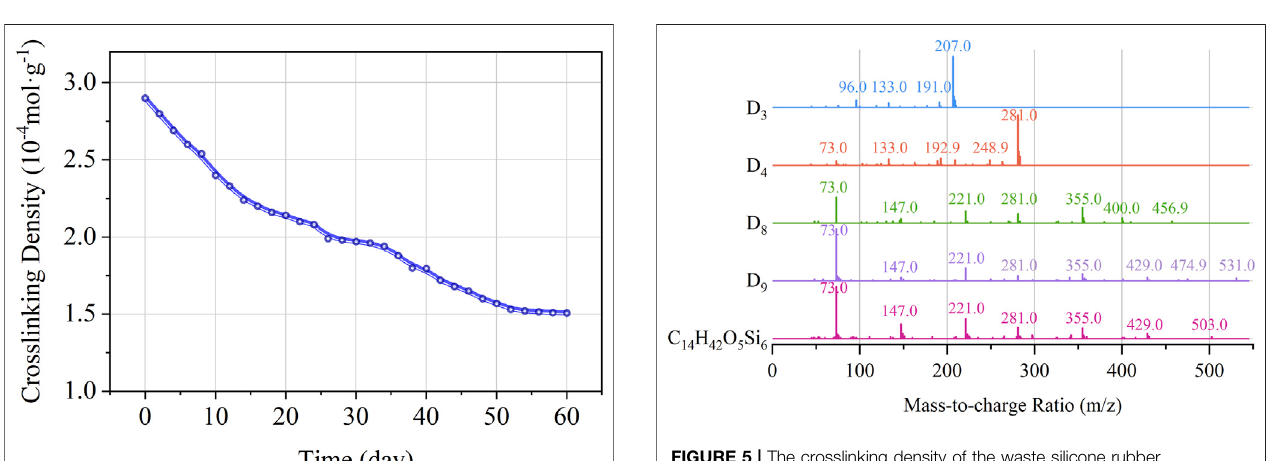
FIGURE 5 | The crosslinking density of the waste silicone